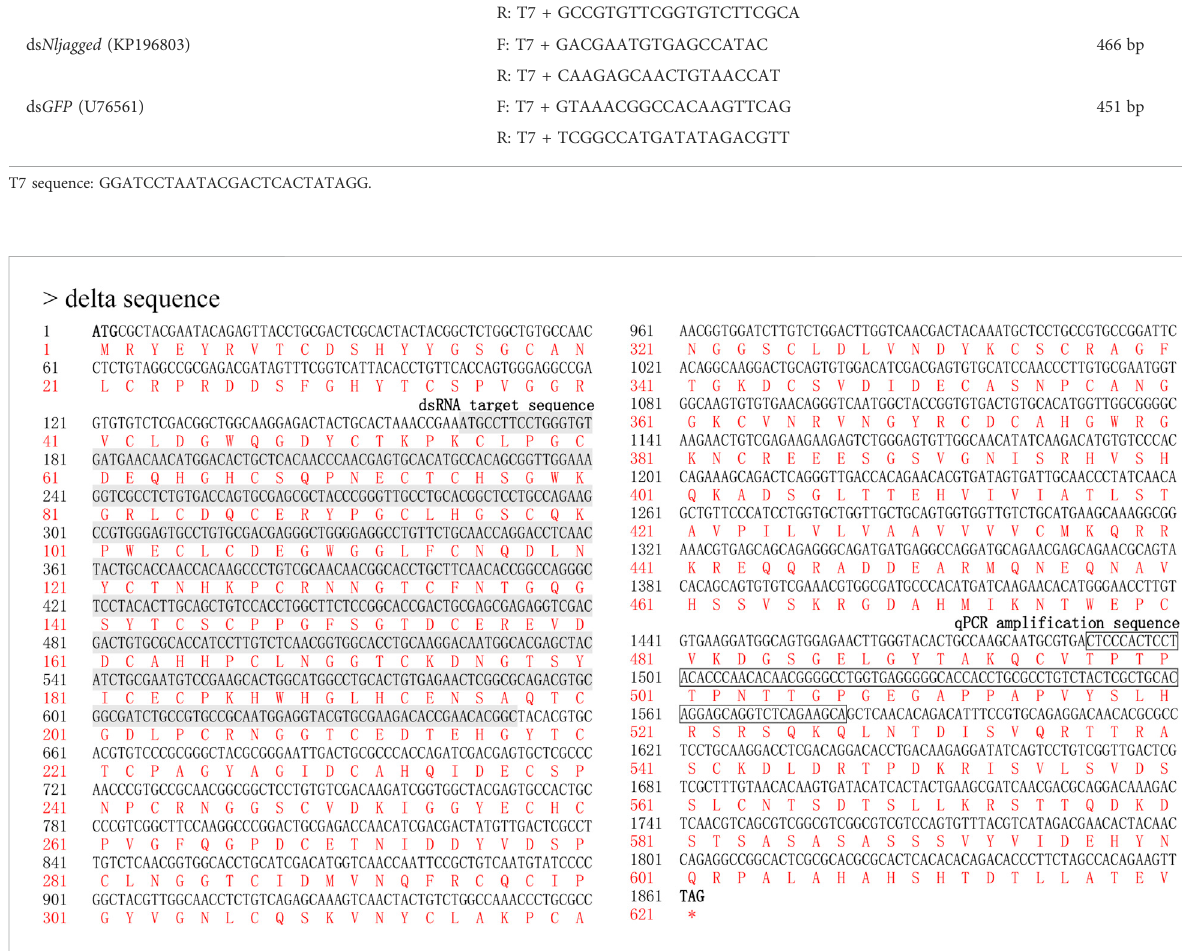
FIGURE 1 Nucleotideanddeducedaminoacidsequenceof Nldelta .Thetargetsequenceofds Nldelta isindicatedingrey;thefragmentampli fi edbyqPCR is indicated by a